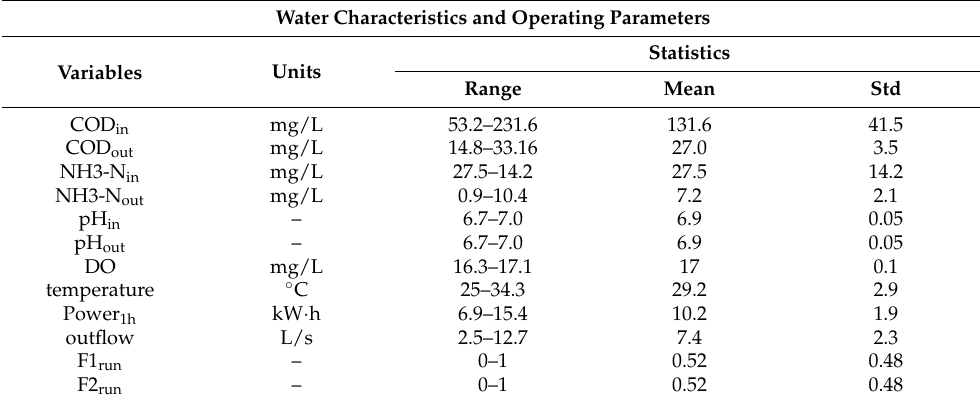
Table 1. Statistics of the original training–validation dataset ( n =